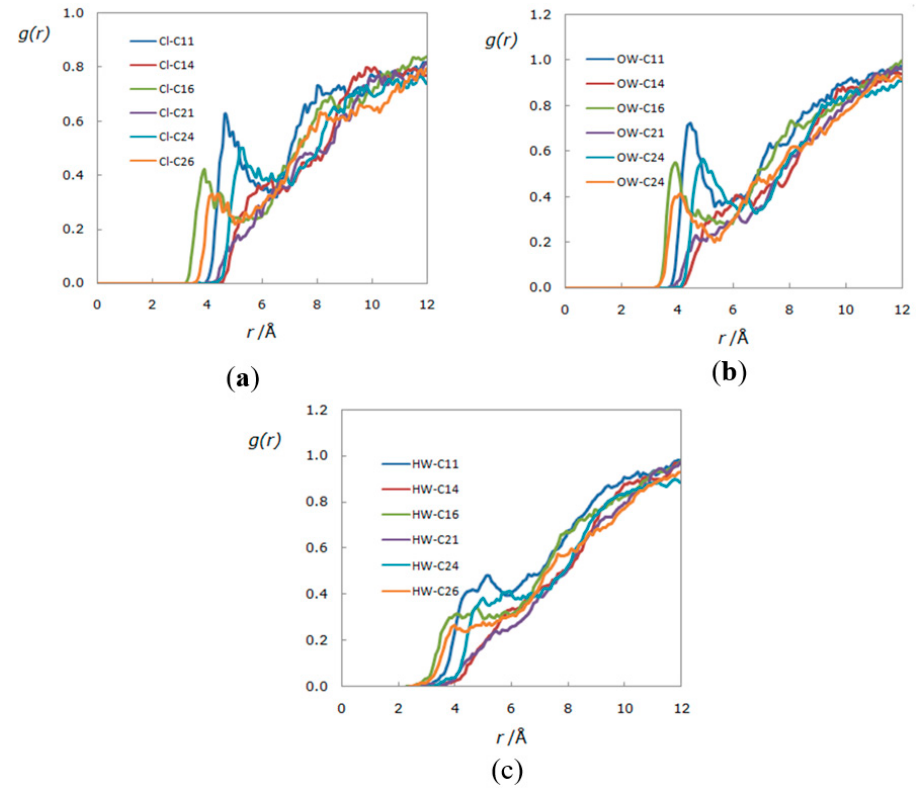
Figure 7. Radial distribution functions of the species at 283.15 K: ( a ) chloride (Cl)–cellulose sites (Cii); ( b ) water oxygen site (OW)–cellulose sites (Cii); ( c ) water hydrogen (HW)–cellulose sites (Cii).